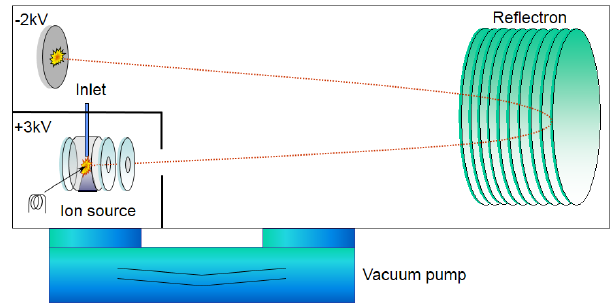
Figure 2. Scheme for the direct ion extraction of the Bench TOF-dx direct extraction (five technologies GmbH, G. Horner and P. Scha- nen, personal communication, 2014). The red dotted line represents a typical ion